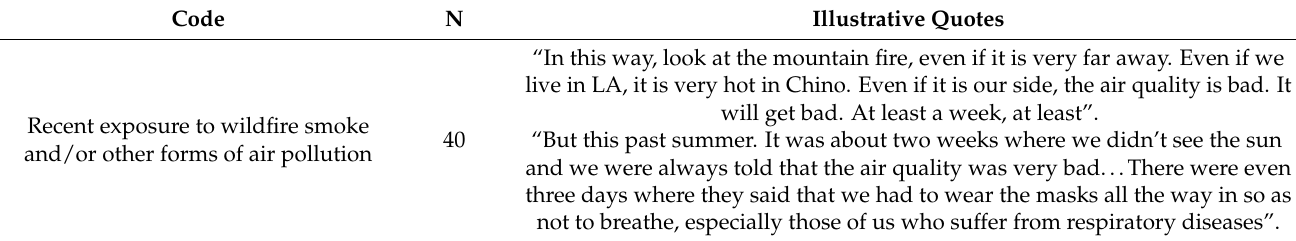
Table 2. Air pollution threat